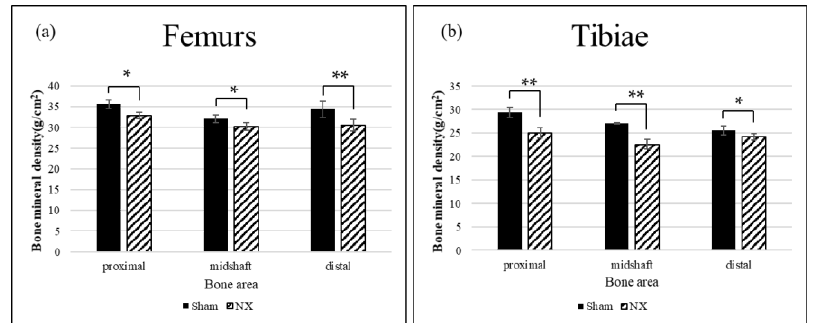
Figure 4. Mean bone mineral density (BMD) of the ( a ) femurs and ( b ) tibiae. The BMD of both the femurs and tibiae was significantly decreased in the NX group compared to the Sham group. * p < 0.05, ** p < 0.01.